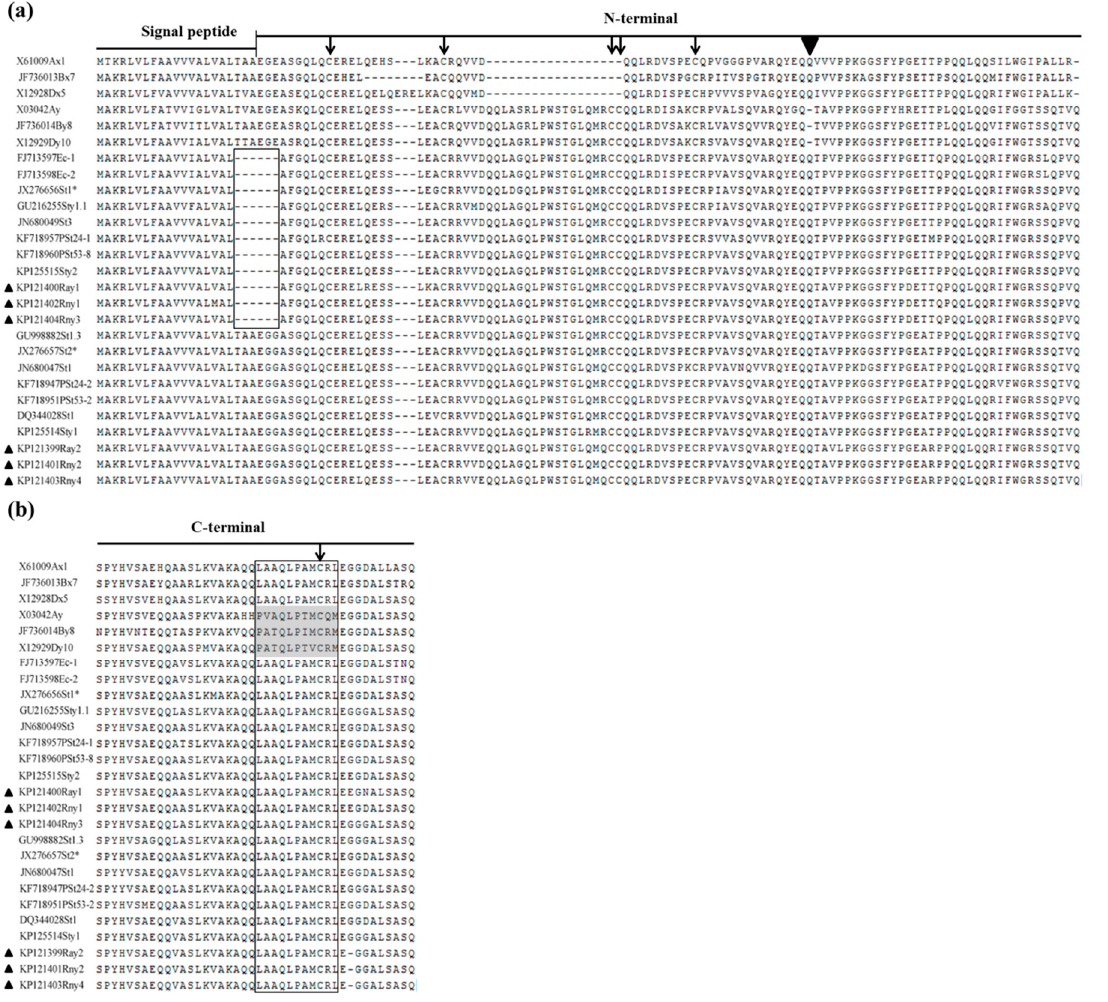
Figure 4. Sequence alignment of the six novel Roegneria HMW-GS genes, along with the other representative HMW-GS genes. ( a ) Signal peptides and N-terminal domains; ( b ) C-terminal domains. The six Roegneria HMW-GS genes are indicated by solid triangles on the left. The deleted hexapeptide crossing signal peptide and N-terminal domain in some subunits, and an undecapeptide (LAAQLPAMCRL) in the C-terminal associated with x-type subunits in wheat are marked by boxes, and the different undecapeptides of y-type subunits in wheat are shadowed. The conserved cysteine residues in the N- and C-terminal domains are indicated by arrows. The extra glutamine residue conserved in the N-terminal of all x-type and some y-type subunits is marked by an inverted solid triangle on top of the subfigure ( a ).